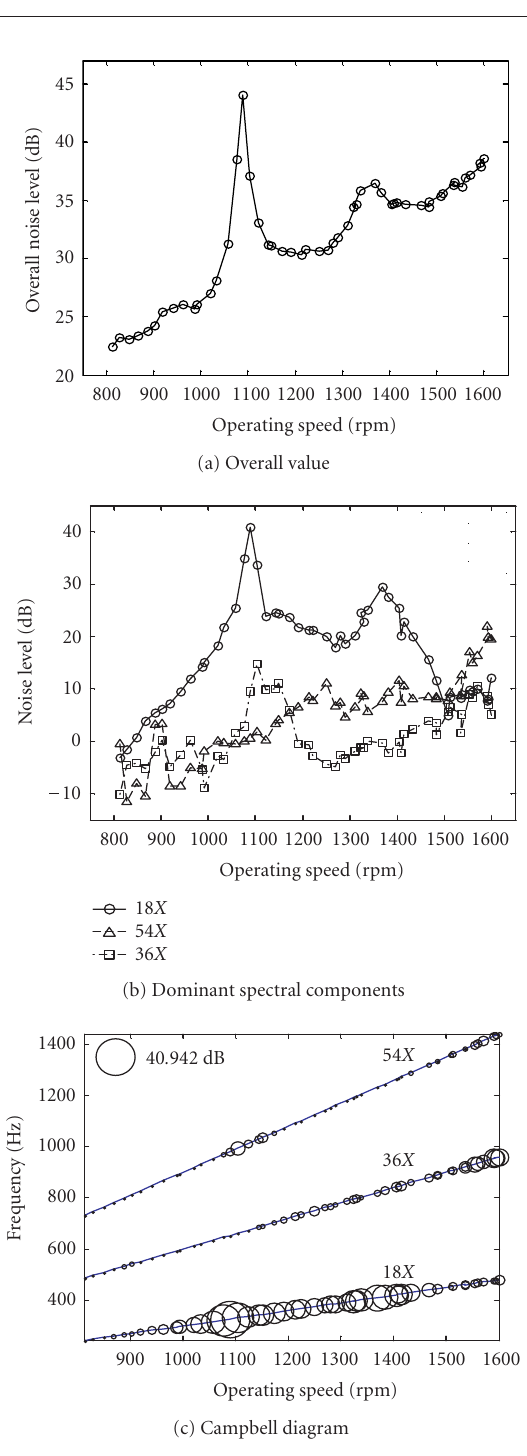
Figure 5: Noise level of original fan-motor